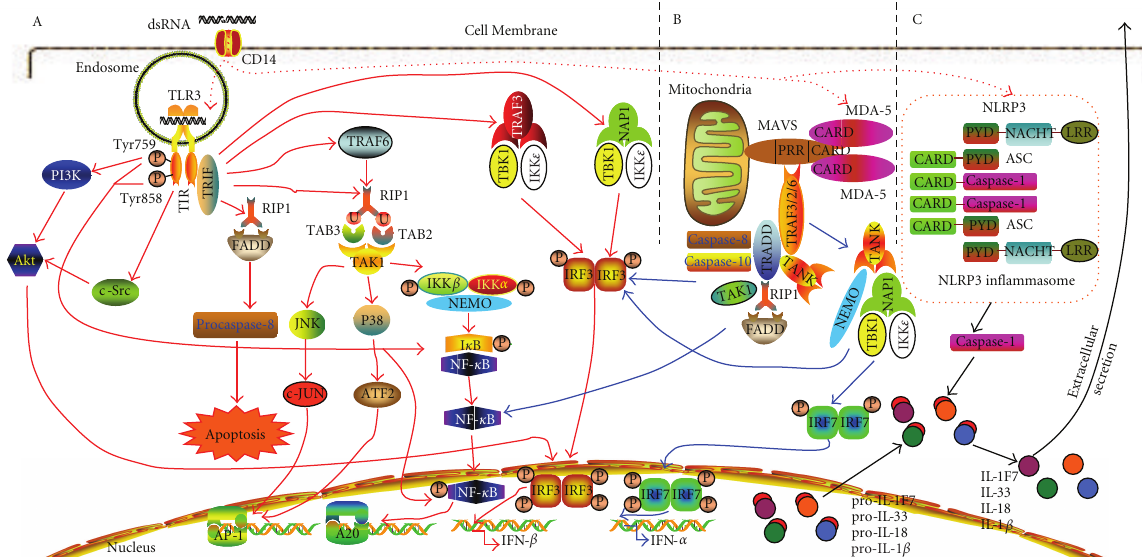
Figure 1: dsRNA induced signal pathways. (A) dsRNA signaling through TLR3 . dsRNA that is internalized into endosome binds to TLR3. The mechanism of dsRNA internalization is unknown, CD14 may play a role. TLR3 possesses two dsRNA binding sites near the N-terminus and C-terminus. When combined with dsRNA, four dsRNA binding sites from two TLR3 molecules that are linked by the sole dsRNA molecule in an “m” shape, and the B-B loop of the TLR3 TIR domain combines with the TIR domain of TRIF. The interaction of TRIF with RIP1 or TRAF6 results in polyubiquitination of RIP1, the latter binds ubiquitin receptors TAB2 and TAB3 which activates TAK1. Activated TAK1 induces phosphorylation of IKK α and IKK β leading to phosphorylation and degradation of I κ B. The release and translocation of NF- κ B to cell nucleus then occurs which results in the specific gene promoter A20 being activated. TAK1 also starts an activation sequence beginning with JNK and p38, which activates c-JUN and ATF2 and this activates the AP-1 transcription factors family. TRIF activates TBK1 and IKK ε through NAP1 and this results in phosphorylation and nuclear translocaton of IRF3 resulting in IFN- β production. TRAF3 also binds with the TBK1/IKK ε complex inducing IRF3 activation. Combination of TRIF results in phosphorylation of Tyr 759 and Tyr 858 in the TLR3 TIR domain which subsequently induces the phosphorylation of, and degradation of I κ B leading to NF- κ B release. Phosphorylated Tyr 759 recruits PI3K and activates kinase Akt for full phosphorylation and activation of IRF3 in nucleus. Tyrosine kinase c-Src also plays a role in Akt activation. TRIF interacts with FADD through RIP1 and activates procaspase-8 to initiate cell apoptosis. (B) dsRNA signaling through MDA-5 . dsRNA is recognized by MDA-5 in cytosol. MDA-5 interacts with MAVS located on the outer mitochondrial membrane via CARD-CARD interaction leading to the dimerization of the MAVS N-terminal CARD domains which subsequently binds TRAF3 directly through the interaction between the TRAF domain of TRAF3 and the TRAF-interacting motif in the PRR of MAVS. Then the RING domain of TRAF3 forms a sca ff old to assemble the noncanonical IKKs signal complex composed of TANK, TBK1, IKK ε , NAP1 and NEMO. This complex activates the signal-dependent phosphorylation of IRF3 and IRF7 to form a functional homodimer or heterodimer which translocate to the nucleus to induce expression of type I IFN. TRAF2 and TRAF6 also associates with MAVS and is involved in activation of P38 MAPK and promotion of IL-12 and type I IFN production or activation of NF- κ B, JNK and P38 signaling. In addition, MAVS recruits TRADD and interacts with TRAF3, TANK, FADD and RIP1 to activate both IRF3 and NF- κ B signaling. (C) dsRNA signaling through NLRP3 inflammasome . NLRP3 recognizes dsRNA by a series of LRRs at the C-terminus. The NACHT domain at the middle of NLRP3 is related to self-oligomerization and the formation of inflammasome. Studies have suggested dsRNA may activate the NLRP3 inflammasome. Activation of NLRP3 results in the interaction of NLRP3 PYD with ASC PYD, and in turn ASC CARD associates with pro-caspase-1 CARD and thereby assembles the NLRP3 inflammasome. Once incorporated into NLRP3 inflammasome, pro-caspase-1 is activated by proteolytic cleavages to remove the CARD prodomain. The active caspase-1 in turn cleaves the IL-1 β , IL-18, IL-33 and IL-1F7 precursors into their active forms and these active cytokines are secreted